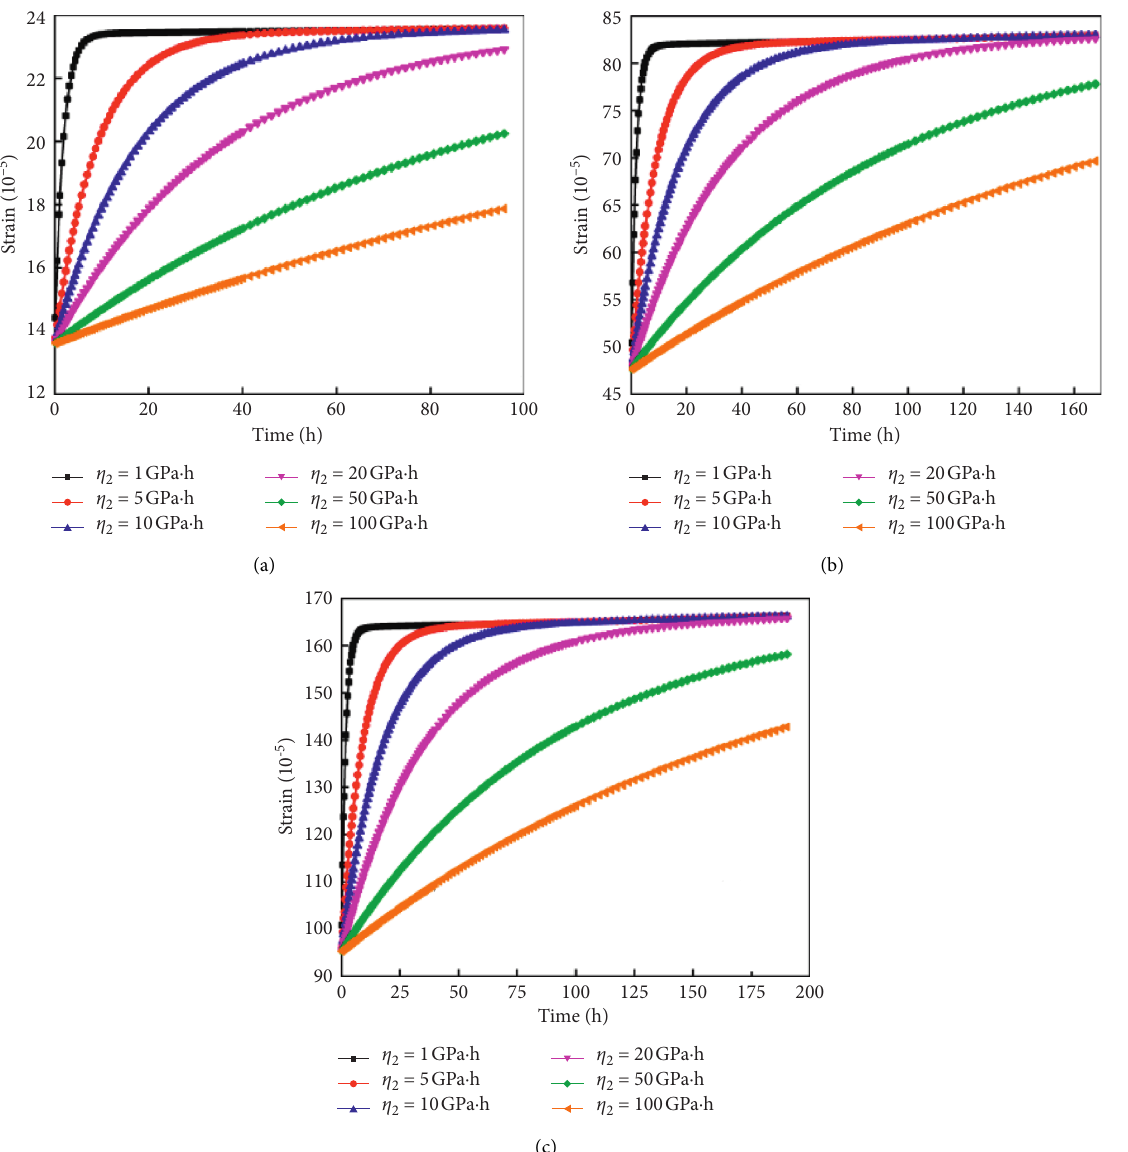
Figure 23: Effect of η 2 on the strain of tunnel anchor under loads of (a) 1.0 N m , (b) 3.5 N m , and (c) 7.0 N m